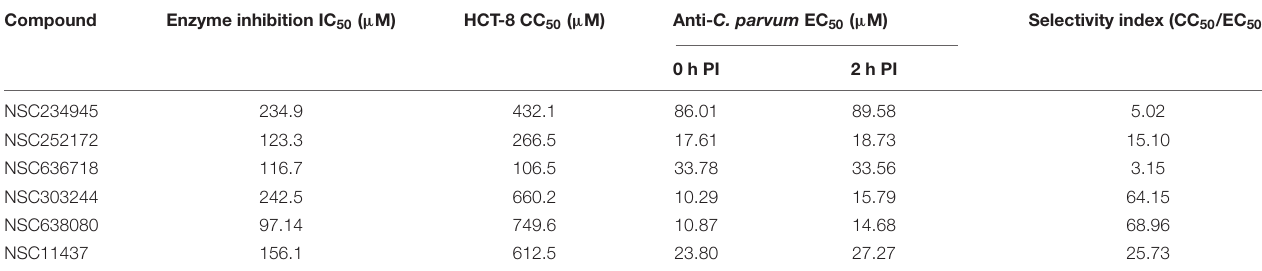
FIGURE 4 | Analysis of the effect of rCpPyK inhibitors on the in vitro growth of C. parvum in HCT-8 cells. Equal amounts of freshly excysted sporozoites of C. parvum were inoculated into HCT-8 cells in culture and compounds at 25 µ M concentration were added immediately after infection. Control infected cells were treated with volumes of DMSO equivalent to those used in the compound-treated cultures. Paromomycin reconstituted in distilled sterile water was added to a separate set of wells as a positive control at 200 µ M final concentration. The cultures were analyzed for parasite infectivity and proliferation by an immunofluorescence assay after 48 h of incubation. The fluorescence generated by intracellular C. parvum parasites was quantified and used to calculate the mean percent parasite inhibition values for each compound. The data shown represent the mean of three independent experiments. Bars represent standard errors of the mean (SEM). TABLE 2 | Enzyme inhibition, cytotoxicity, in vitro efficacy, and selectivity index values of selected compounds.